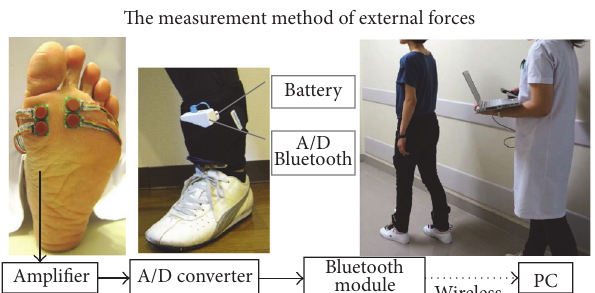
Figure 1: The state of attaching the sensors at the 1st and 2nd meta- tarsal head.